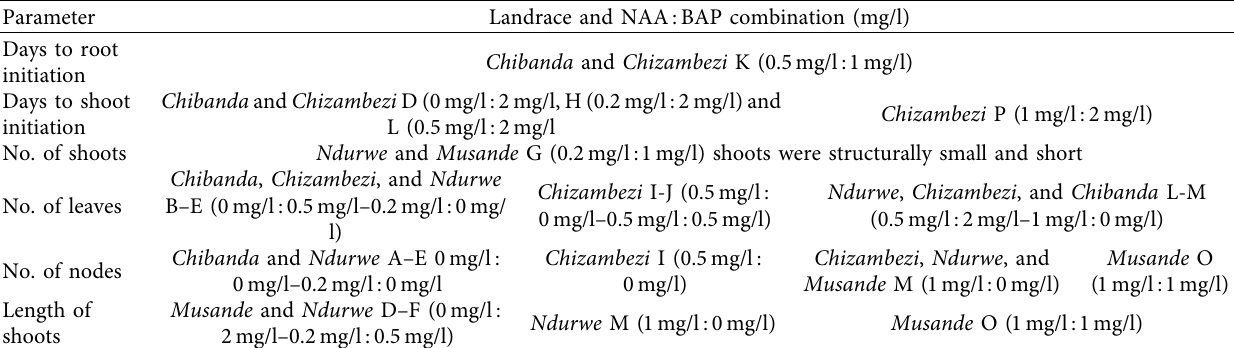
Figure 6: Mean shoot length of the livingstone potato landraces in response to NAA: BAP in mg/l application. P < 0 . 001, LSD � 1.53. Error bars represent standard errors of the differences. Plant growth regulators key: A (0mg/l :0mg/l), B (0mg/l:0.5 mg/l), C (0mg/l :1mg/l), D (0mg/l: 2mg/l), E (0.2mg/l :0mg/l), F (0.2mg/l: 0.5mg/l), H (0.2mg/l:2 mg/l), I (0.5mg/l :0mg/l), J (0.5mg/l :0.5mg/l), J (0.5mg/l: 0.5mg/l), K (0.5mg/l:1 mg/l), L (0.5mg/l: 2mg/l), M (1mg/l :0mg/l), N (1mg/l :0.5mg/l), O (1mg/l:1 mg/l), and P (1mg/l :2mg/l). Table 4: Summary of landrace performance due to application of